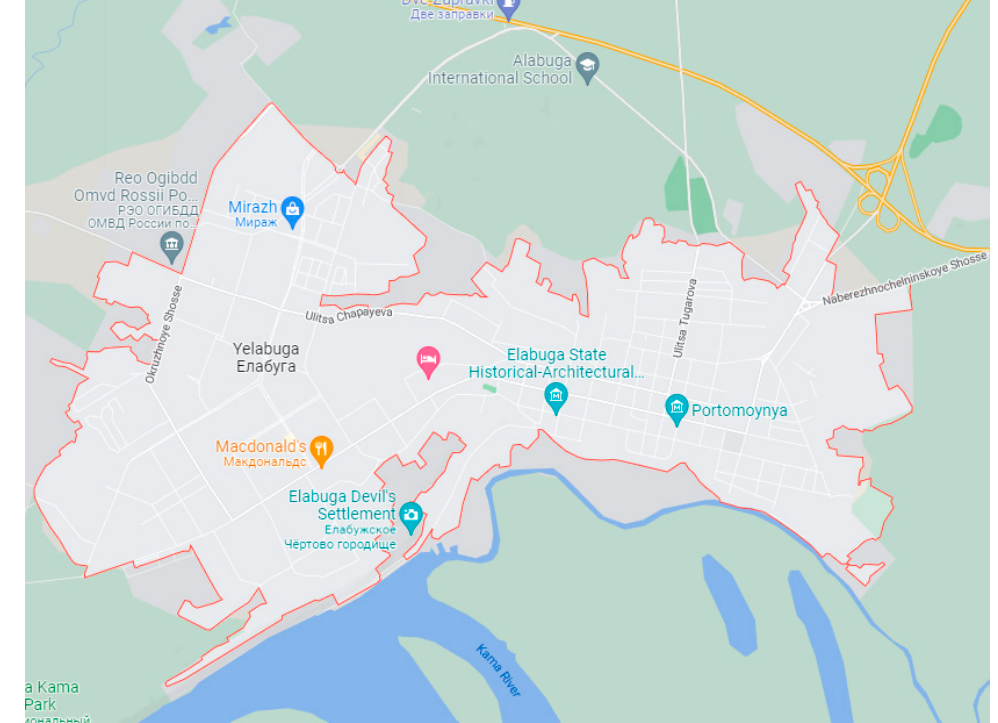
Figure 2. Map of the town of Elabuga (adapted from opensource [29]).